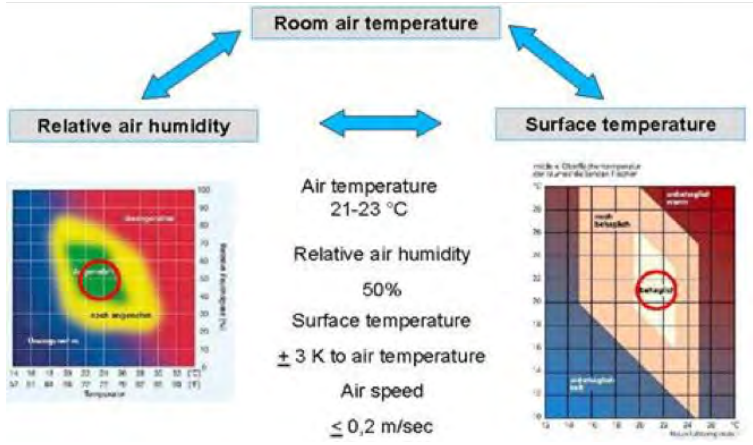
Figure 1. Comfortable